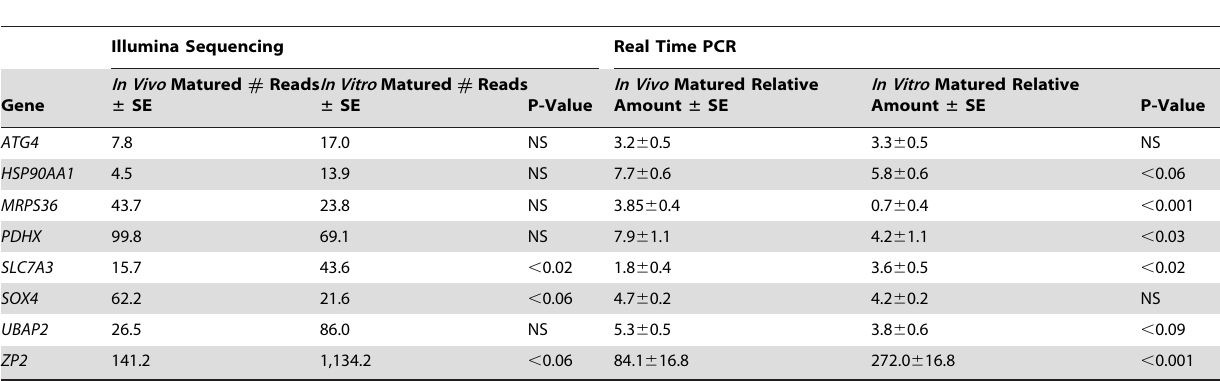
Table 3. Transcript abundance of selected genes as determined by Illumina sequencing and real time PCR.